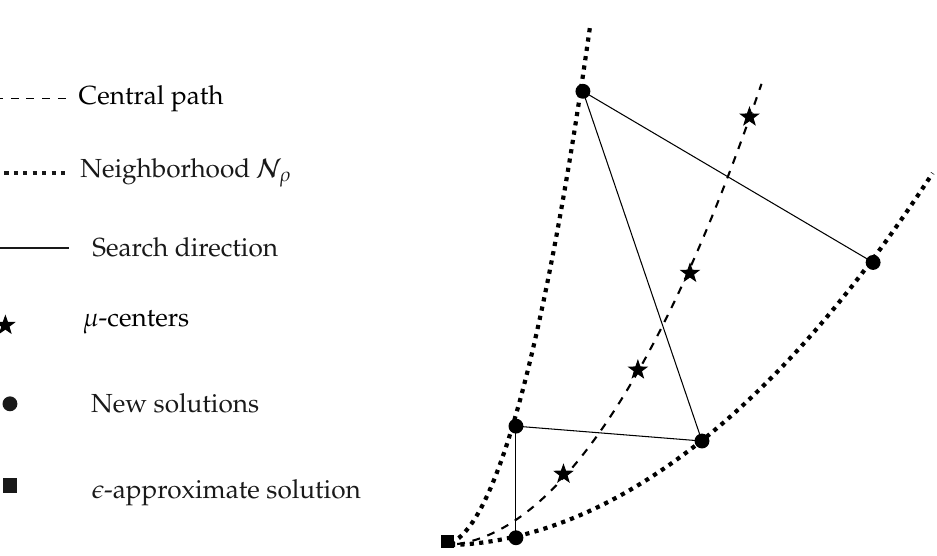
Figure 5.1. Alternating between steps to follow the central path. Figure 1. The alteration between steps to follow the central